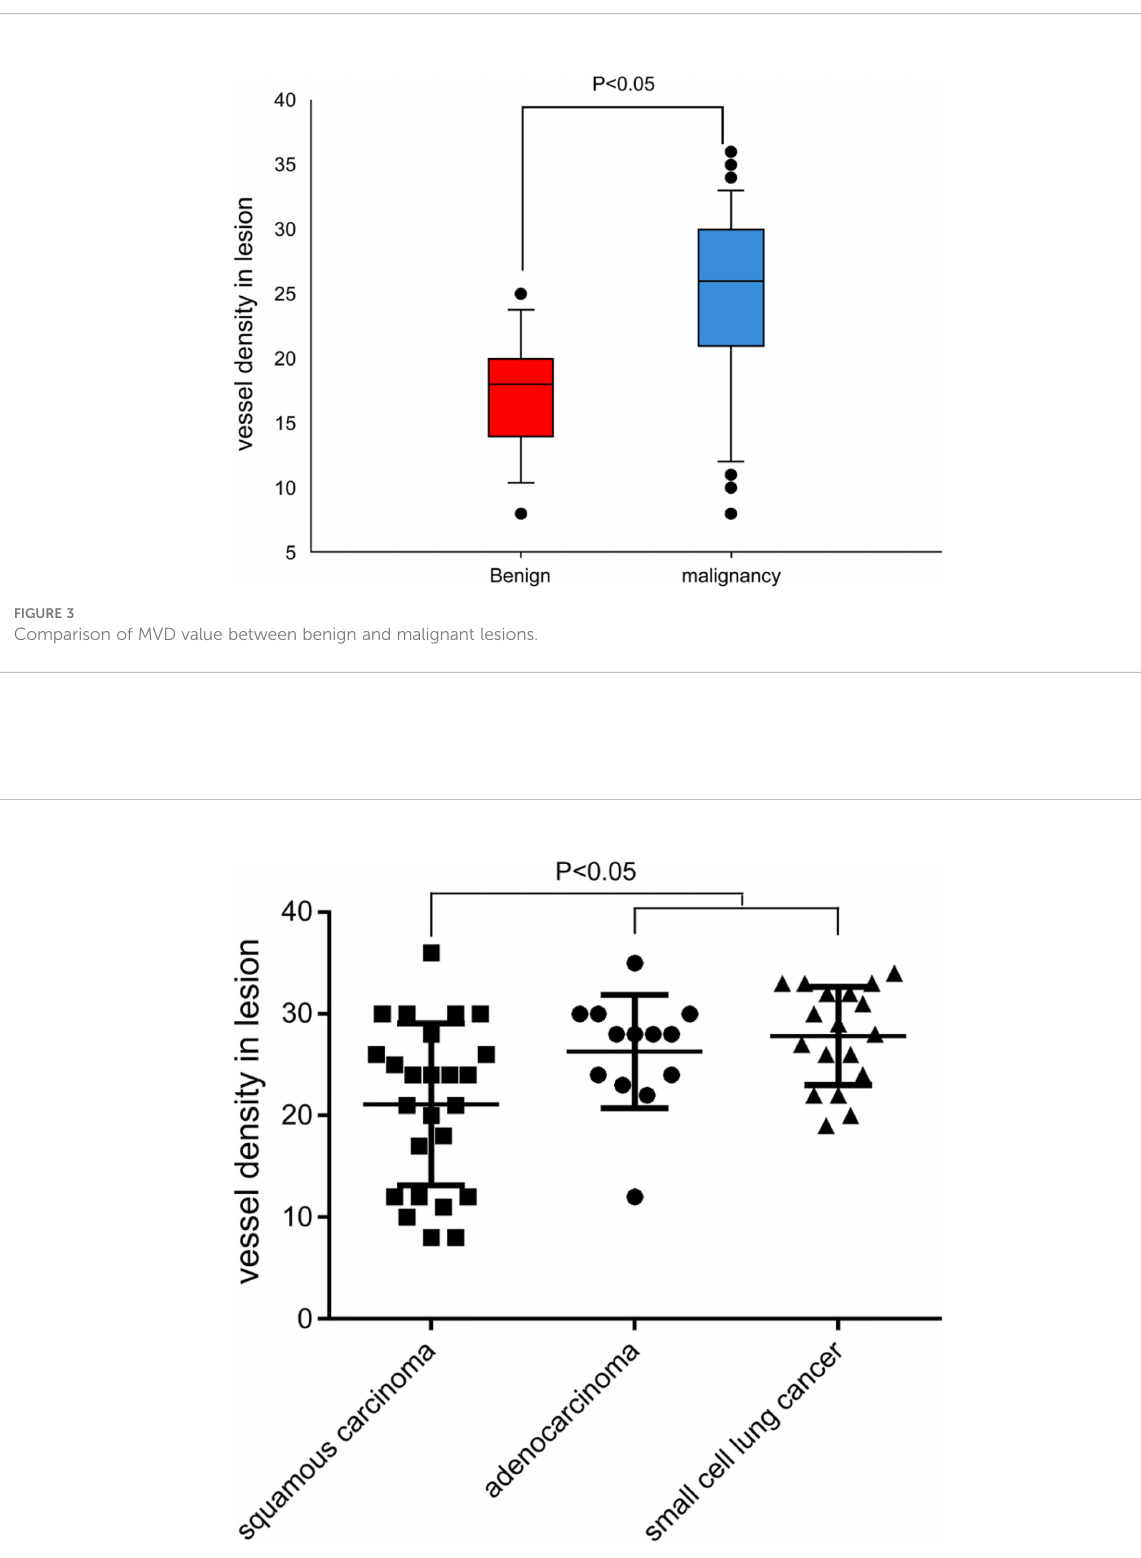
FIGURE 4 Comparison of MVD value for SCC, adenocarcinoma, and